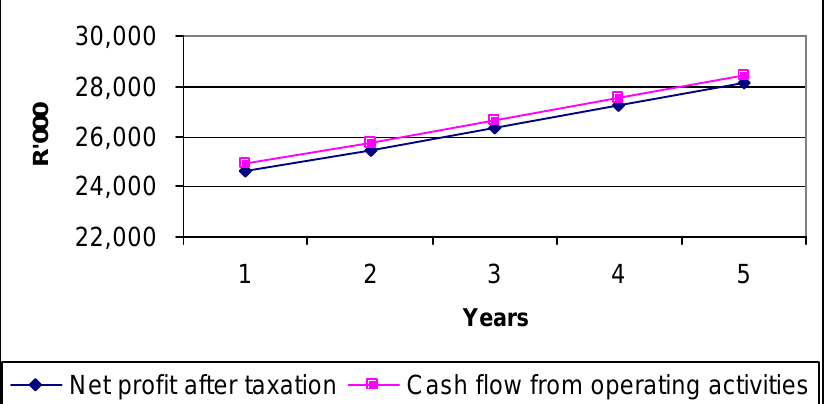
Figure 4: A low growth rate, high non-cash working capital and a high net profit ratio